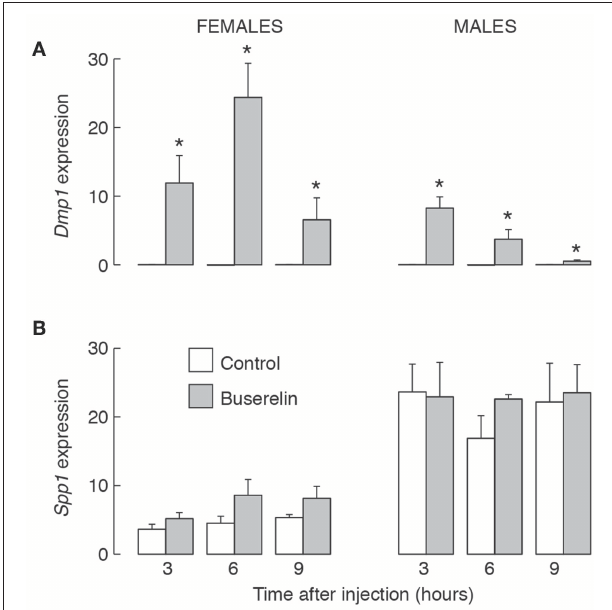
FIGURE 9 | The lack of an effect of GnRHR agonist injection in vivo on Spp1 mRNA expression in anterior pituitary gland. Prepubertal (4-week-old) female and male rats were injected with buserelin acetate, a GnRHR agonist (5 µ g/0.4ml per animal or solvent (0.4ml PBS) intraperitoneally. Three, 6 or 9h after injection, anterior pituitary glands were removed and qRT-PCR analysis for Dmp1 (A) , Spp1 (B) , and Gapdh was performed; asterisks indicate significant differences vs. the corresponding solvent injected animals; p < 0.05 or